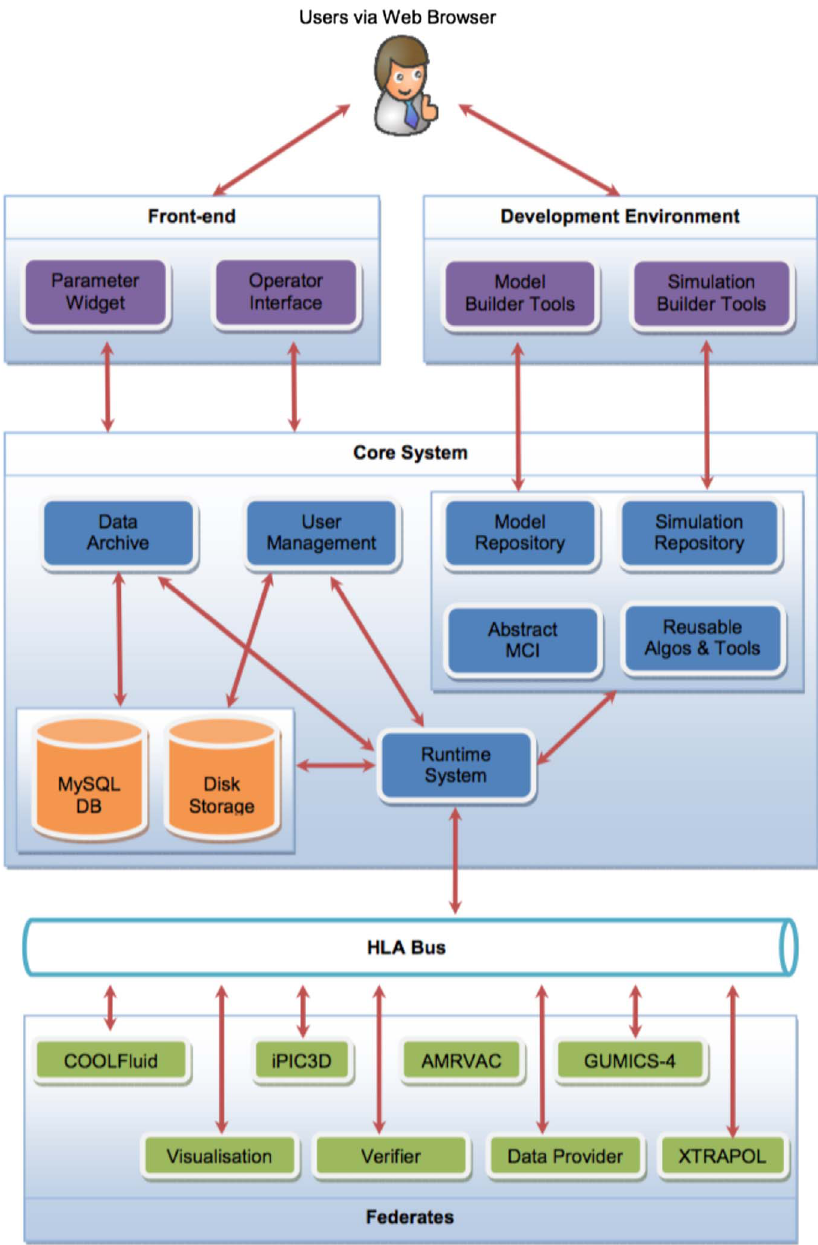
Fig. 2. VSWMC-P2 system requirements